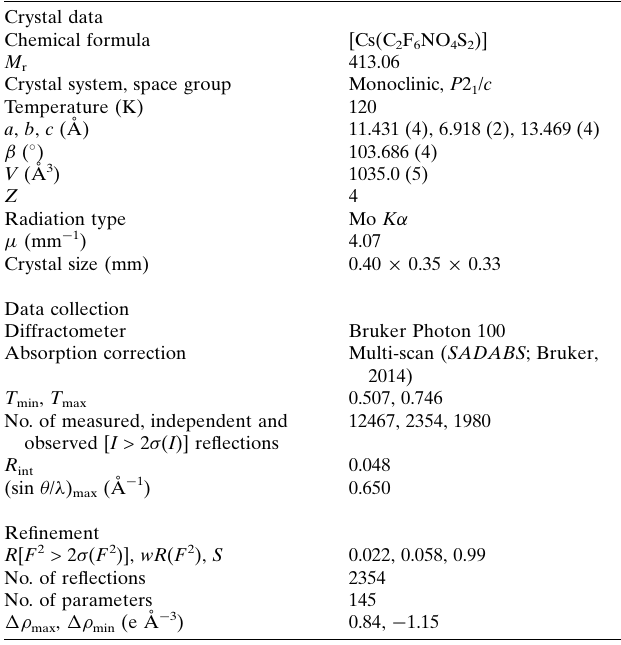
Table 2 Experimental details. Crystal data Chemical